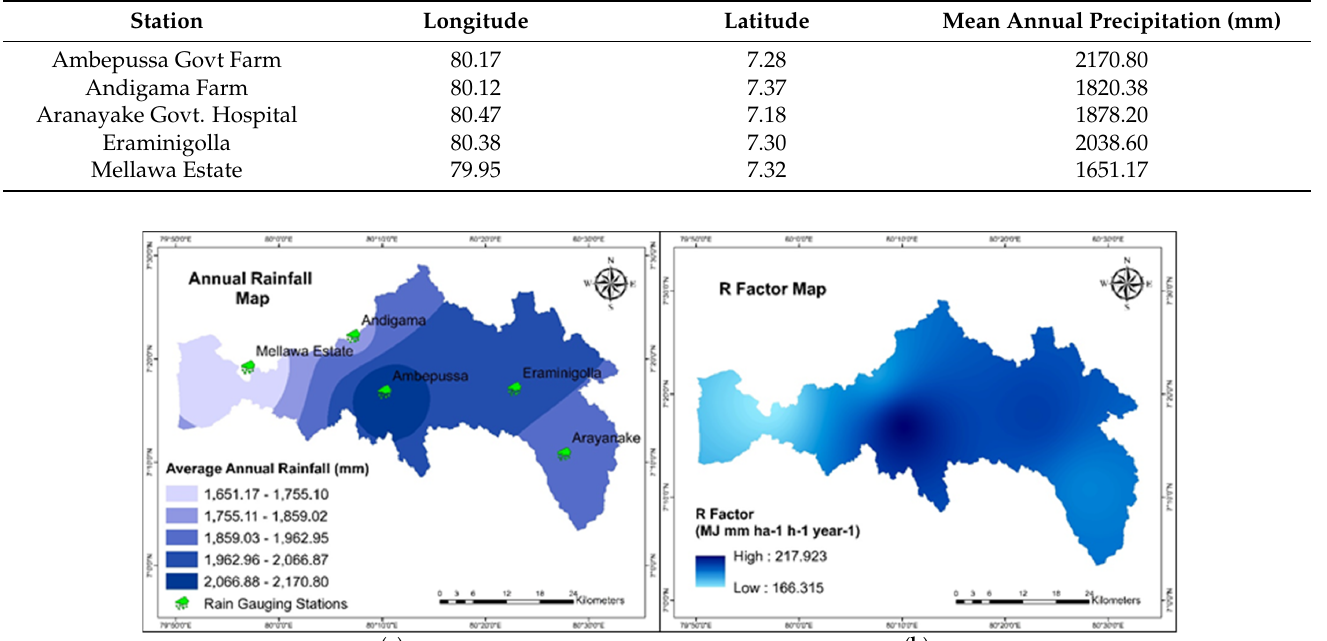
Figure 8. ( a ) Average annual rainfall map and ( b ) Rainfall erosivity (R) factor map of the Maha Oya River Basin.